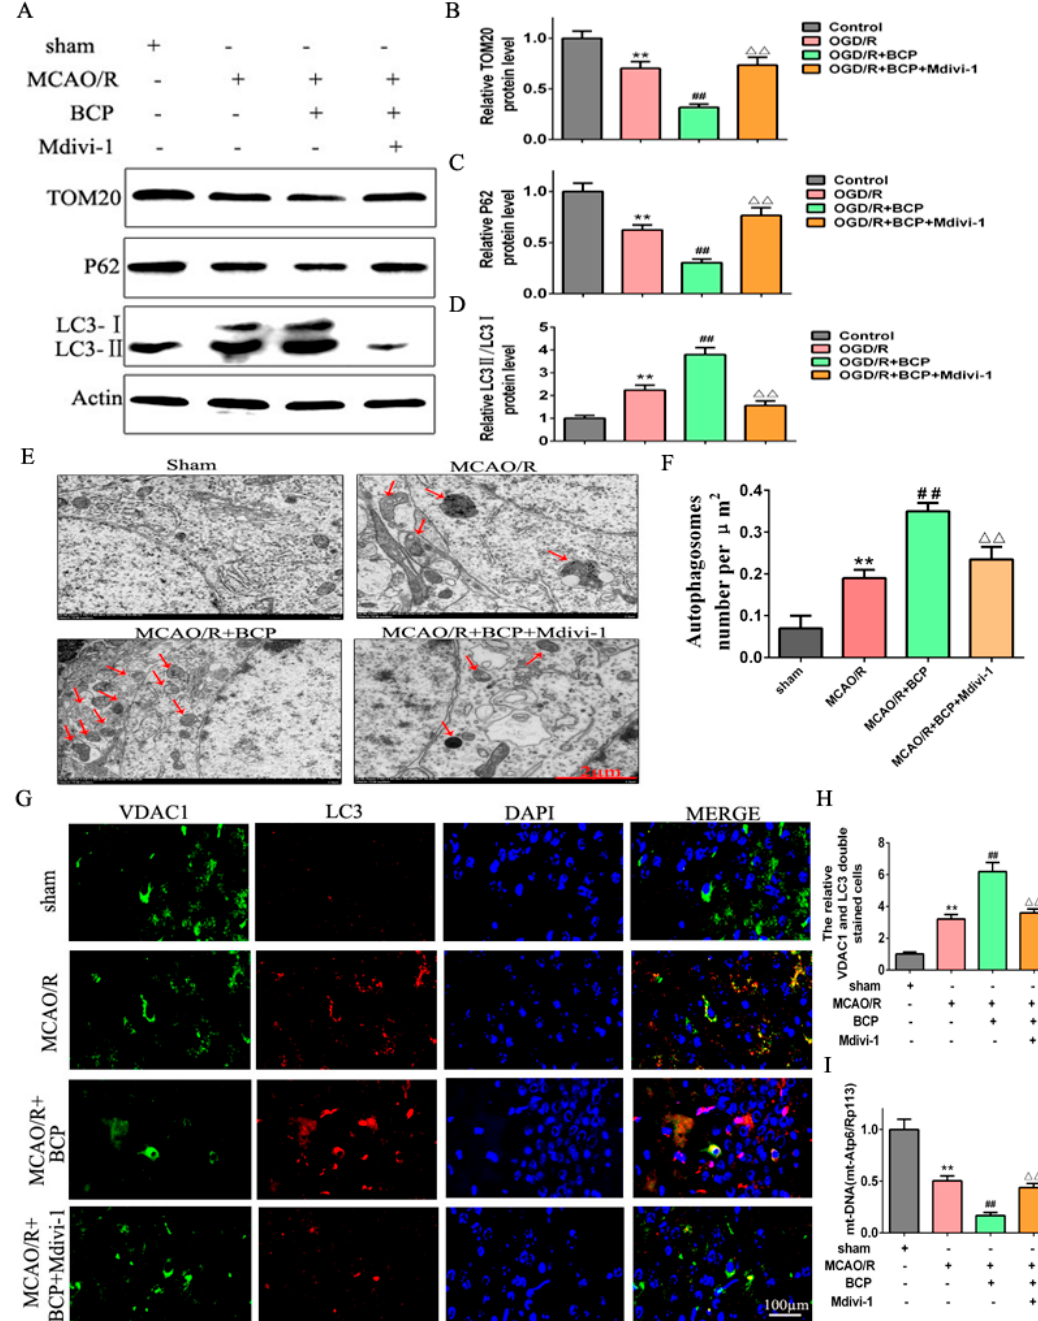
Figure 9. BCP facilitated mitophagy after CIR injury in C57BL/6 mice. ( A – D ) Representative Western blots showing protein levels of p62 and TOM20, and the protein ratio of LC3-II/LC3-I. p62 and TOM20 protein levels were normalized to β -actin. ( E , F ) Transmission electron microscopy revealed numbers of autophagosomes in hippocampal CA1 sections of MCAO/R mice. Red arrows indicate autophagosomes. ( G , H ) Double-immunofluorescence staining for LC3B and VDAC1 in ischemic hippocampal CA1 sections after reperfusion. VDAC1 (red) and LC3B (green) double-stained cells (yellow) indicate mitophagy (scale bar = 100 µ m, 400 × magnification). ( I ) Relative mitochondrial DNA levels (indicated by the ratio of mt-Atp6 to Rpl13) were assessed by real-time PCR. (( A – I ), n = 6; ** p < 0.01 MCAO/R group vs. sham group; ## p < 0.01 MCAO/R + BCP group vs. MCAO/R group; (cid:52)(cid:52) p < 0.01 Mdivi-1 group vs. BCP